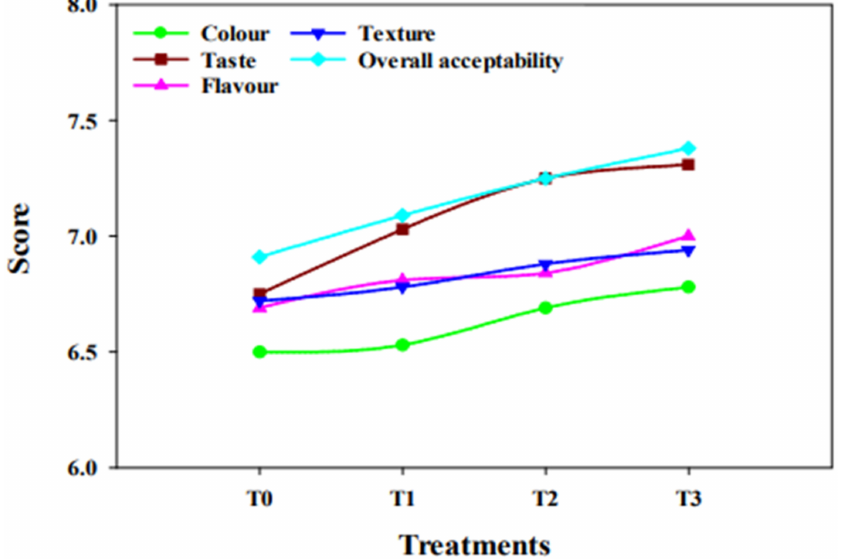
Figure 3. Effect of treatment on sensory properties of